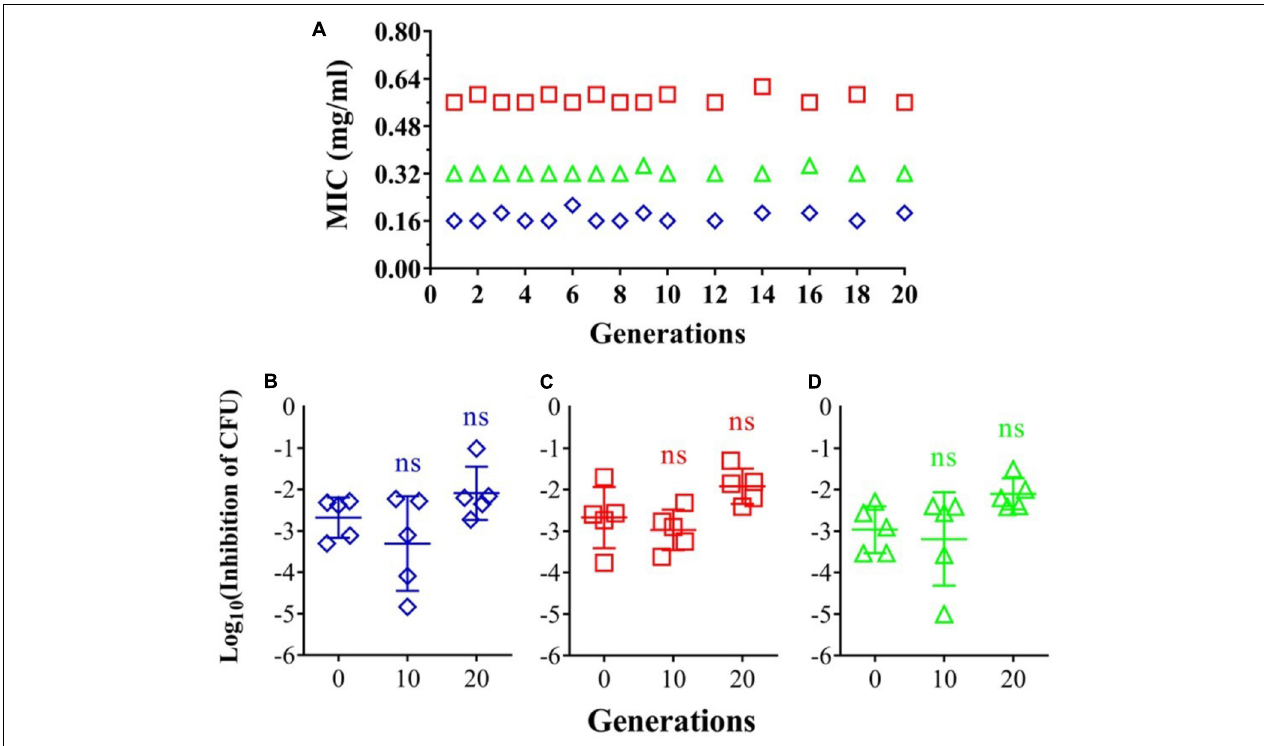
FIGURE 3 | Possible development of bacterial resistance to oregano oil. (A) A. baumannii AF0005, P. aeruginosa IQ0042, and MRSA IQ0064 were passaged for 20 generations each in the presence of indicated MIC doses of oregano oil. The inhibition rate of A. baumannii AF0005 (B) , P. aeruginosa IQ0042 (C) , or MRSA IQ0064 (D) was unaltered when the bacteria of indicated generations were exposed to oregano oil at an initial MIC concentration. ns, no significance.